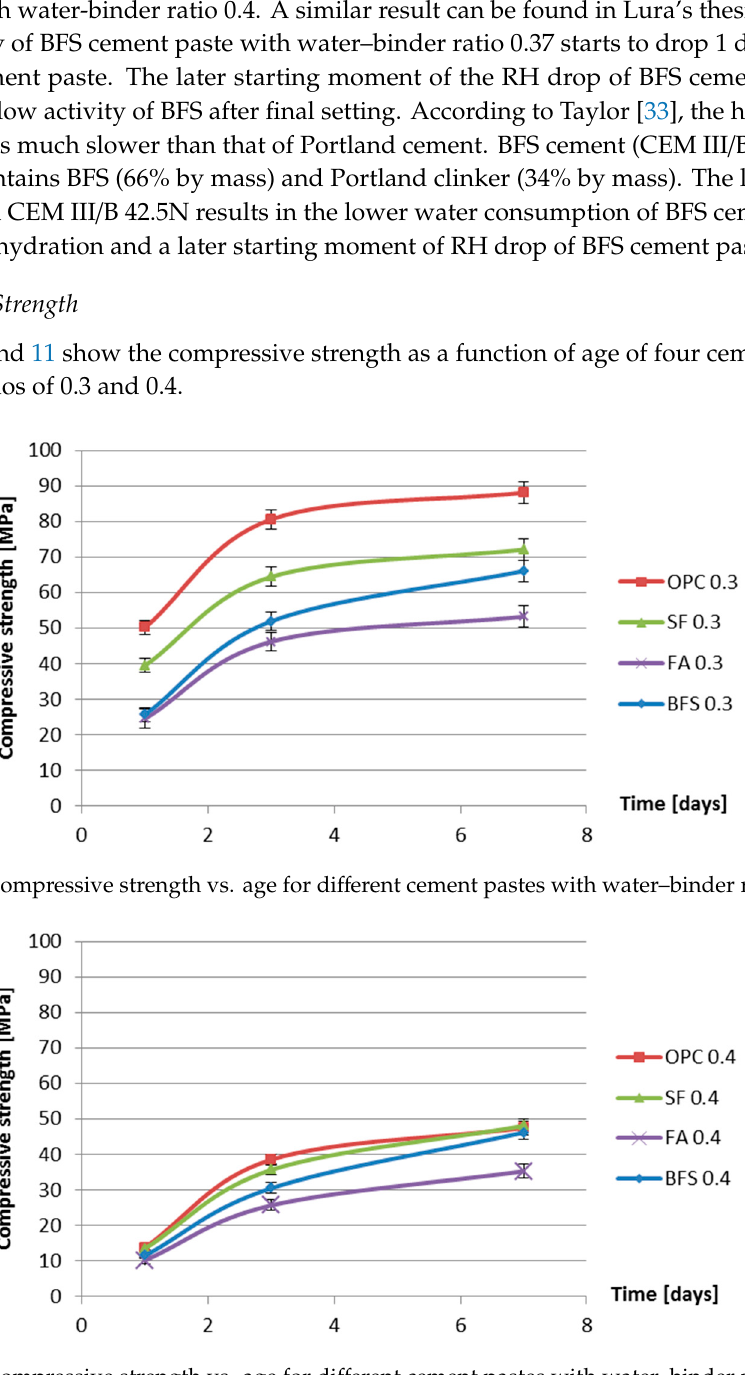
Figure 11. Compressive strength vs. age for di ff erent cement pastes with water–binder ratio of